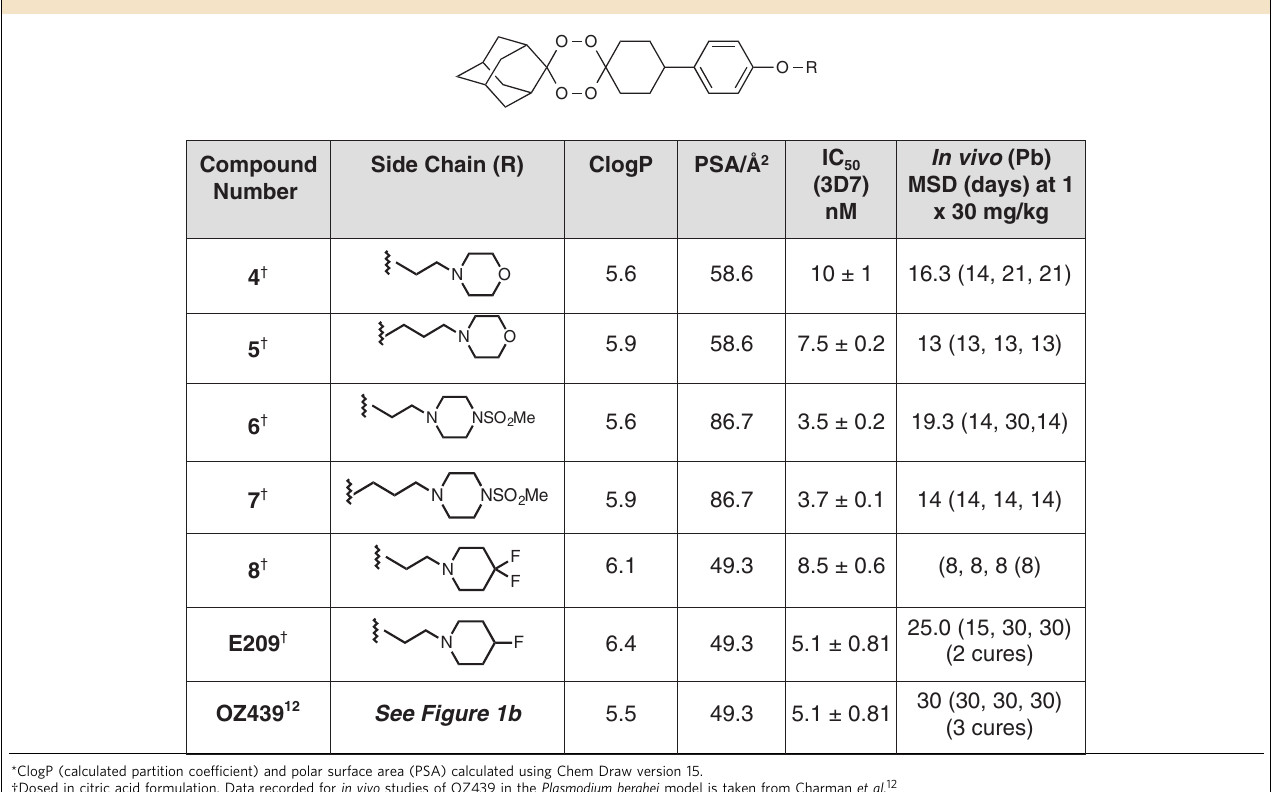
Table 1 | Calculated physicochemical* properties and in vitro and in vivo antimalarial activity z profiles of selected tetraoxane